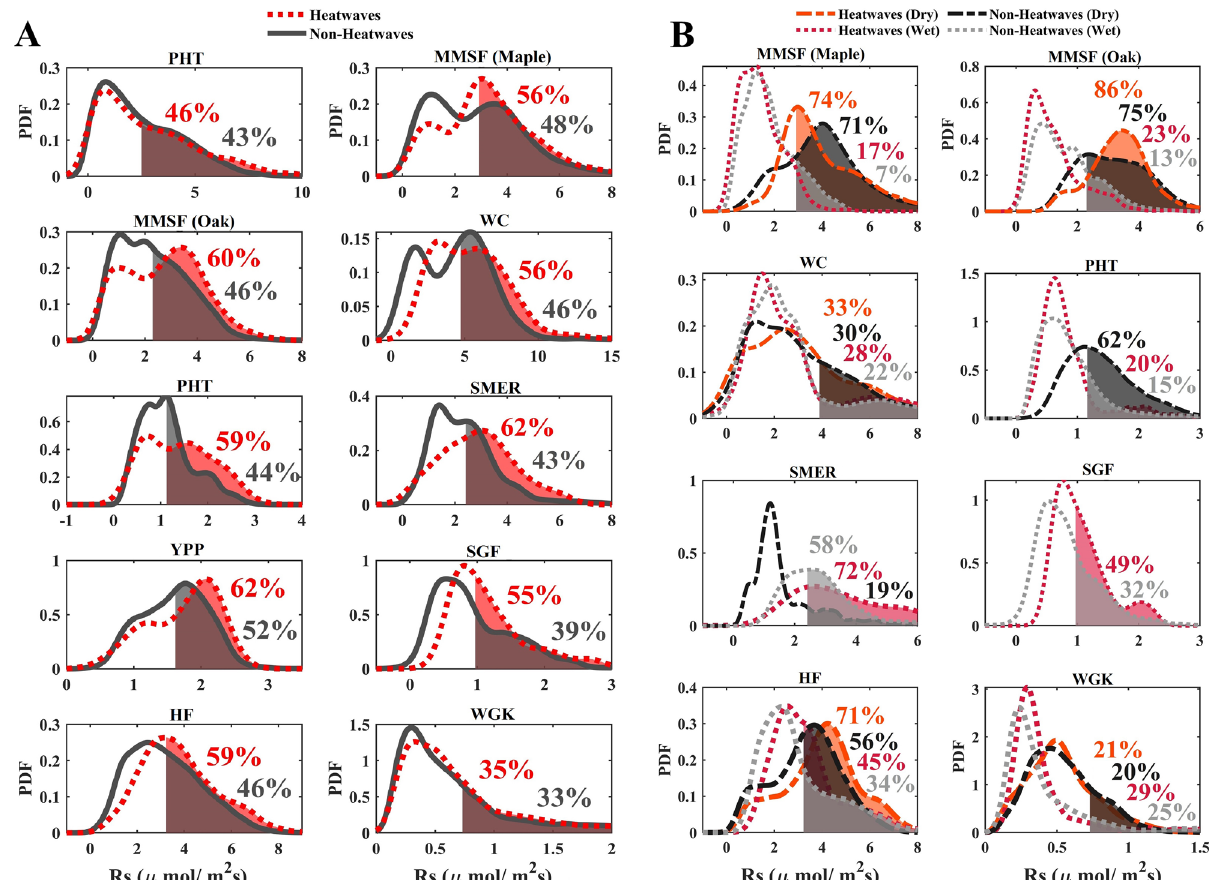
Figure 5. PDFs of soil respiration for the eight individual study sites. ( A ) PDFs of soil respiration given heatwaves and non-heatwaves. Shaded areas denote soil respiration exceeding its average rate and the percentages indicate the corresponding exceedance likelihoods. ( B ) PDF conditioned on heatwave/non- heatwave and two soil moisture regimes (i.e., dry and wet conditions). Some PDFs are excluded from the panels due to lack of data points, which if used may lead to a misrepresentation of the underlying relationships (see Materials and increase with longer and more severe heatwaves as expected in the future 1 . Given that the previous in-situ observations have not considered the Rs response to heatwaves (e.g., rate, amount), the terrestrial feedback to the carbon cycle may be largely underestimated without capturing the effects of heatwave events (and possibly other short-term extreme events).